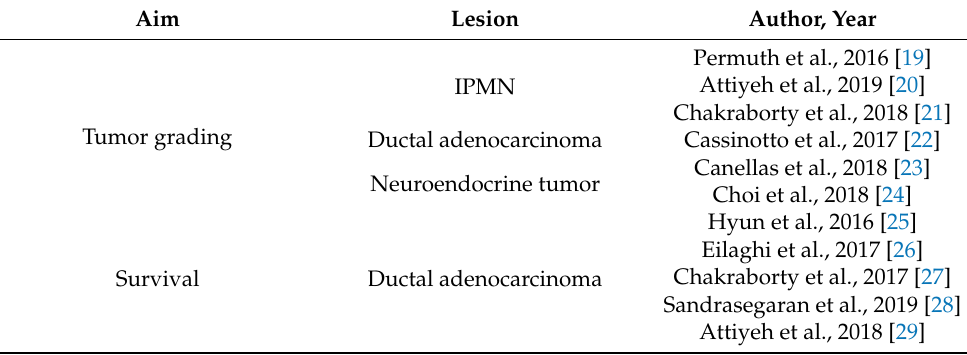
Table 7. Previously published radiomics studies involving pancreatic